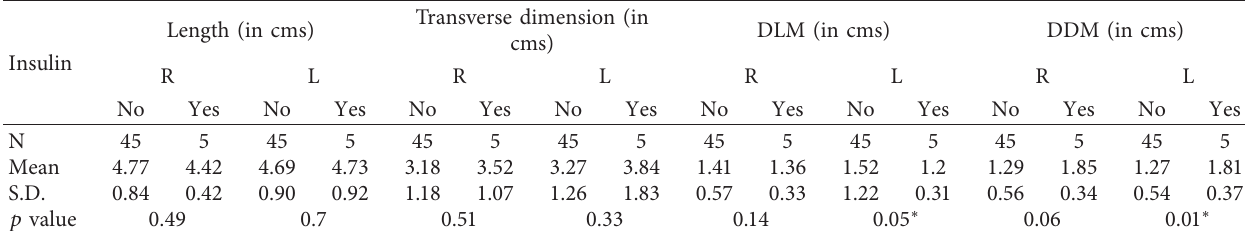
∗ Significant p value.